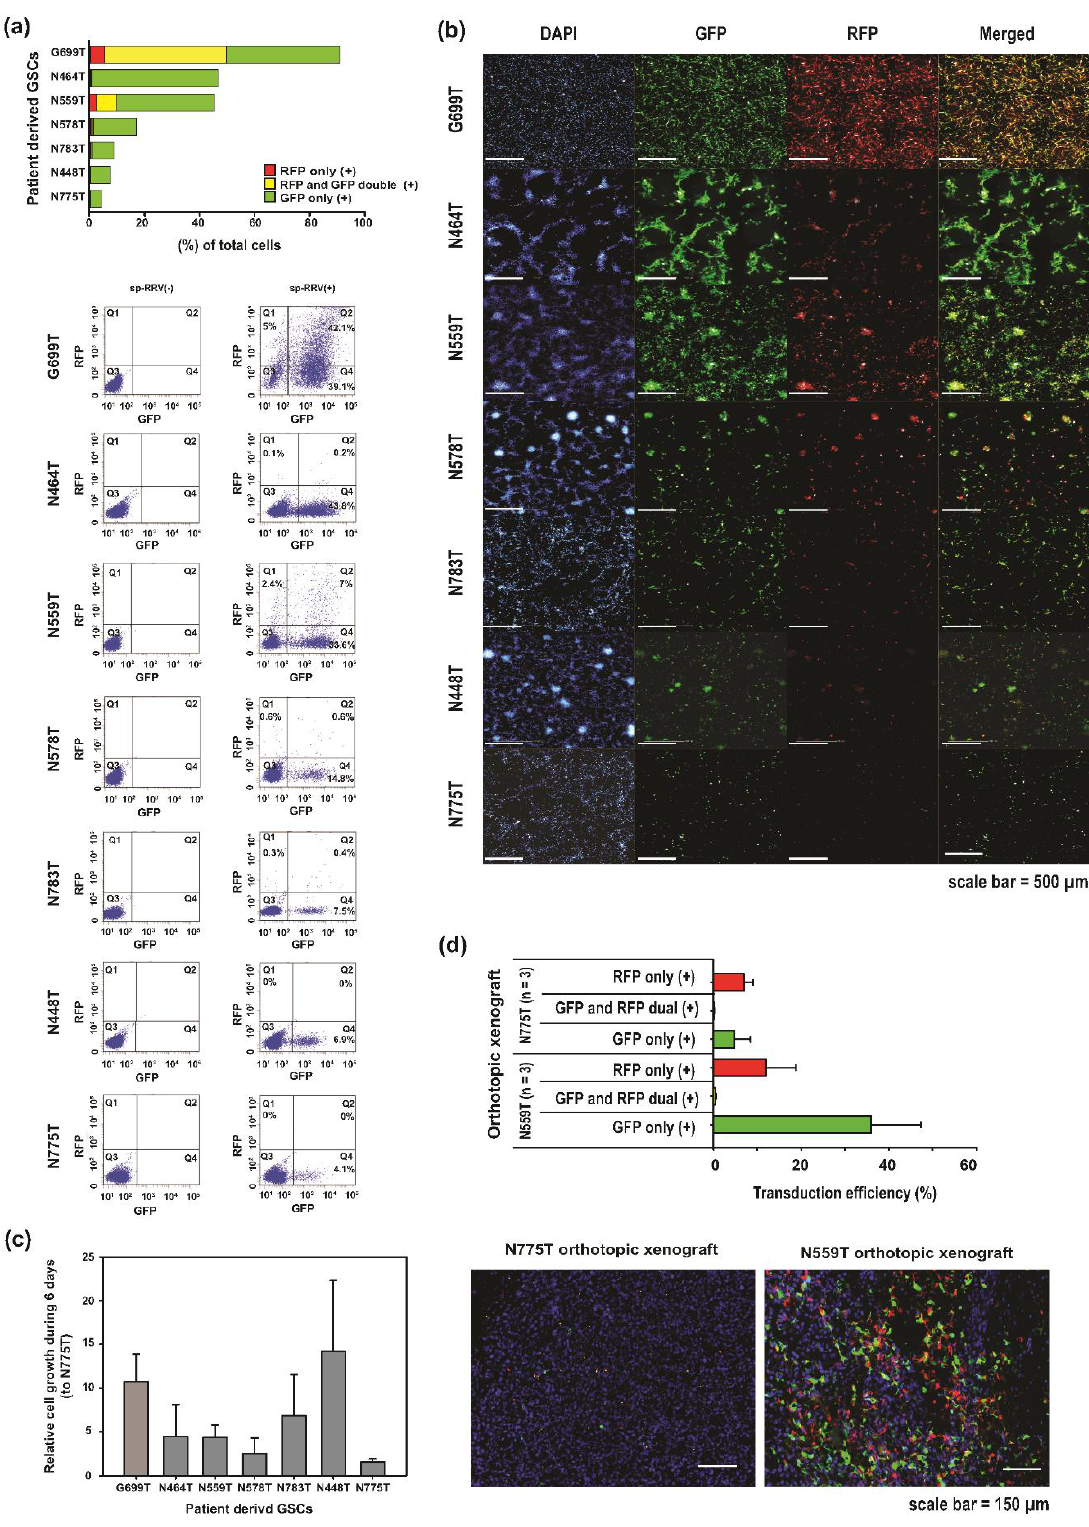
Figure 2. Patient-derived glioblastoma stem-like cells (GSCs) show diverse levels of susceptibility to sp-RRV system carrying spRRVe-GFP and sRRVgp-RFP vectors. ( a ) In vitro infectivity of sp-RRV carrying spRRVe-GFP and sRRVgp-RFP vectors in seven patient-derived GSCs. The graph indicates the percentage of GFP (single positive), RFP (single positive), and GFP and RFP (double-positive) cells as determined by fluorescence-activated cell sorting analysis on day 6 (Upper, bar plot; Lower, scatter plot). Each cell type was initially infected with spRRVe-GFP and sRRVgp-RFP vectors at a multiplicity of infection (MOI) of 1. ( b ) Representative immunofluorescence images of seven patient-derived GSCs